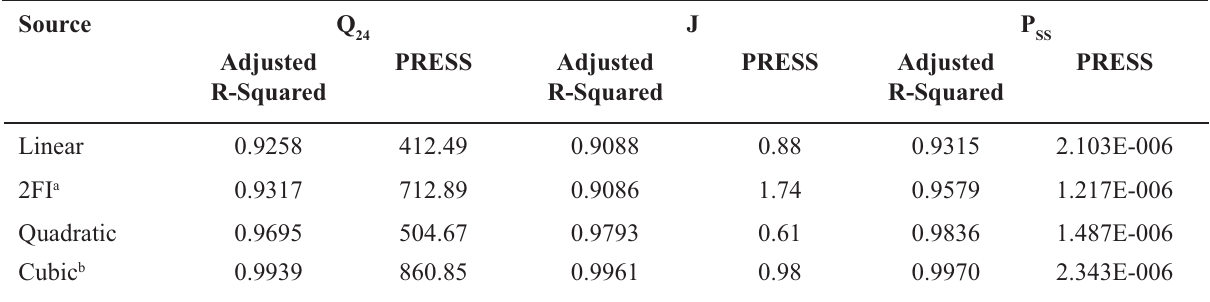
a two factor interaction; b aliased model not to be selected; PRESS = predicted residual error sum of